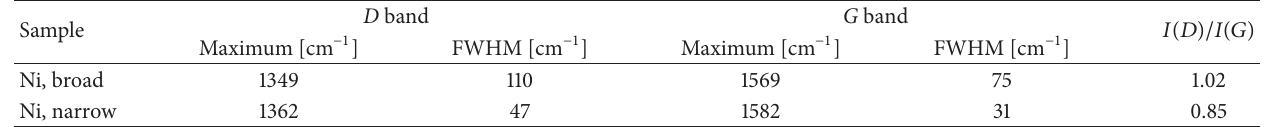
Table 3: Properties of 𝐷 and 𝐺 bands recorded for reference Ni/ 𝑛 -SiC contact.